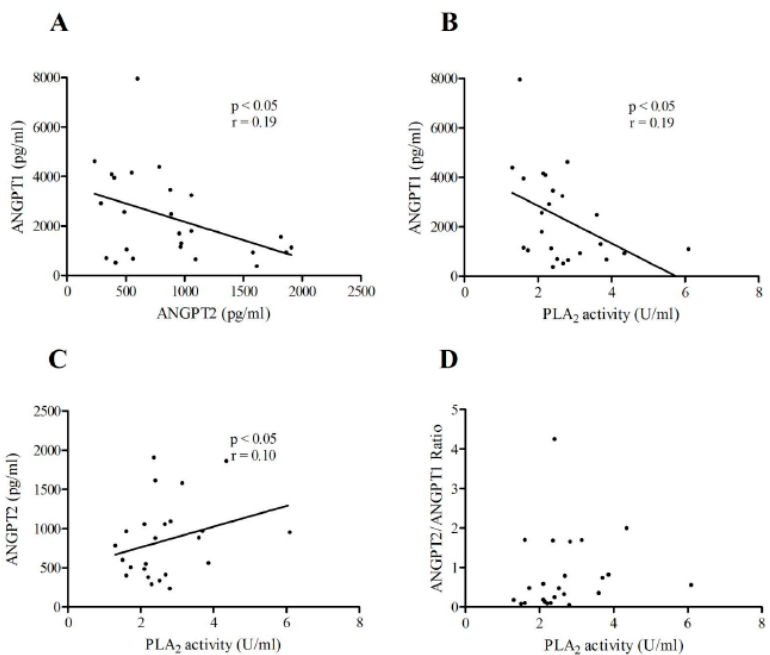
Figure 7. ( A ) Correlations between the plasma concentrations of ANGPT2 and ANGPT1 in NIHF patients; ( B ) correlation between circulating sPLA 2 activity and the concentration of ANGPT1 in NIHF patients; ( C ) correlation between the plasma concentration of sPLA 2 activity and ANGPT2 in NIHF patients; ( D ) correlation between the plasma concentration of sPLA 2 activity and the ANGPT2/ANGPT1 ratio in NIHF patients. Spearman’s correlation coefficients ( r ) were calculated and are shown in the panels.